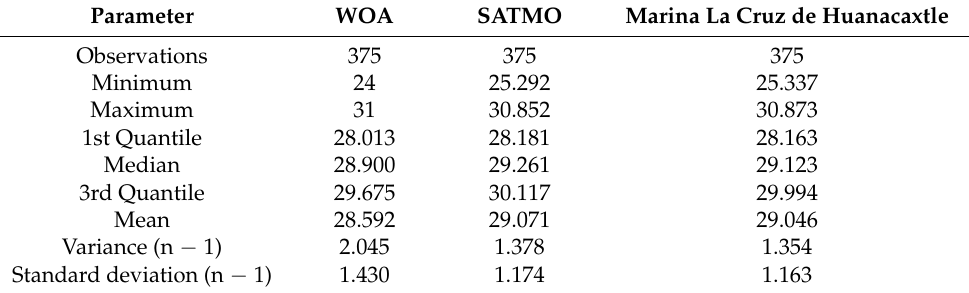
Table 6. Parameters of the descriptive